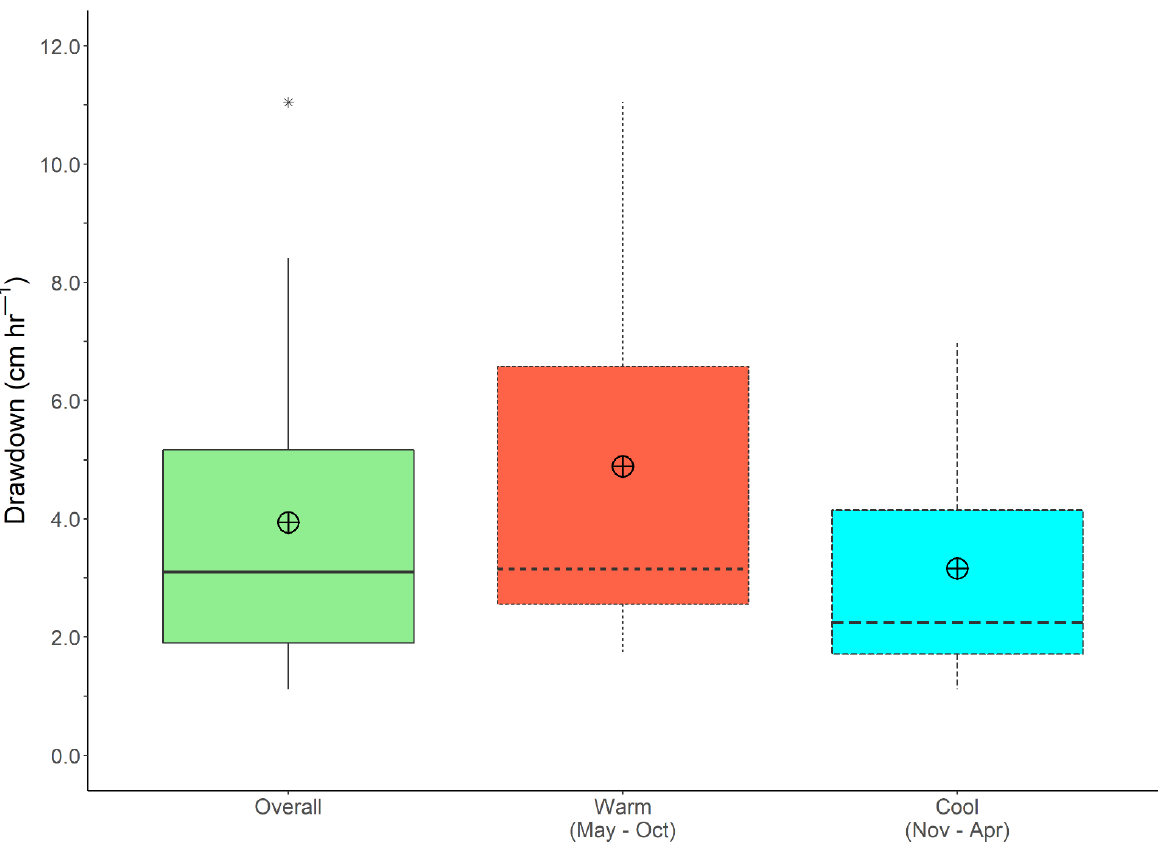
Figure 4. Water level drawdown in the dry detention basin during the warm season, cool season, and overall. Statistical outliers are shown as (*).